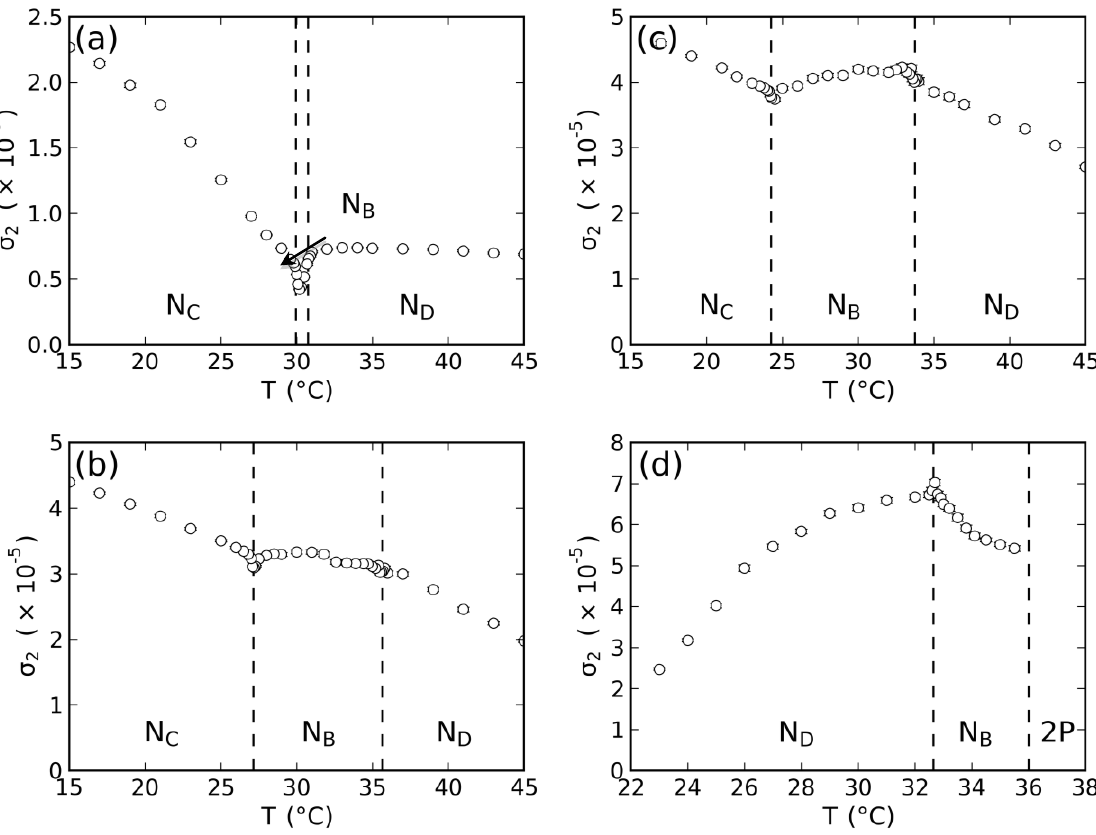
SO /DDeOH/water; ( b ) DL -KDDS/Na 2 4 SO /DDeOH/ water; and ( d ) DL -NaDDAs/Cs 2 4